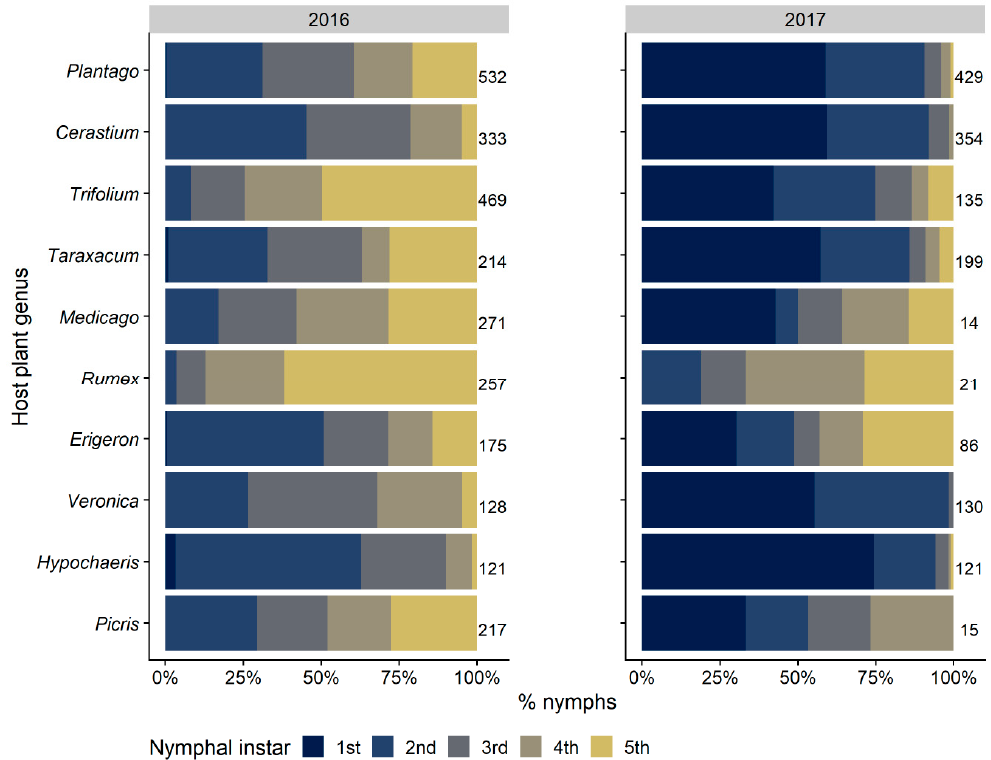
Insects 2021 , 12 , x FOR PEER REVIEW 14 of 25